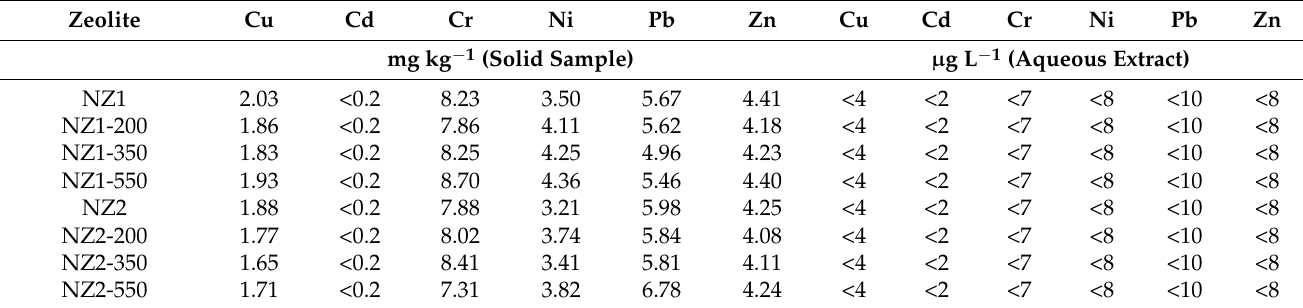
Table 2. Concentrations of heavy metals in solid and aqueous extract of NZ1, NZ2 and thermally treated NZ samples ( n = three parallel determinations).